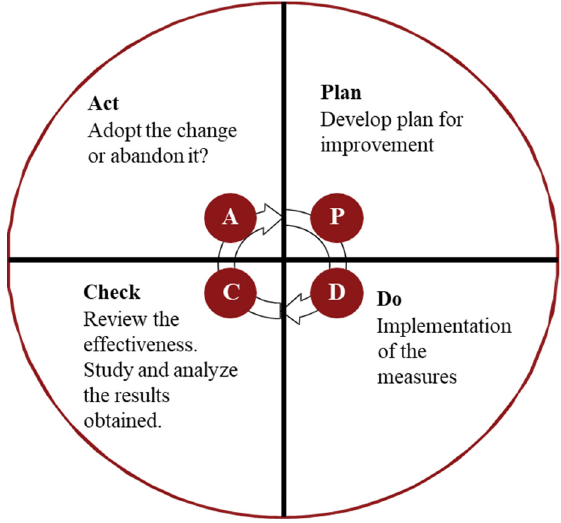
Figure 1. Plan–Do–Check–Act (PDCA) cycle.